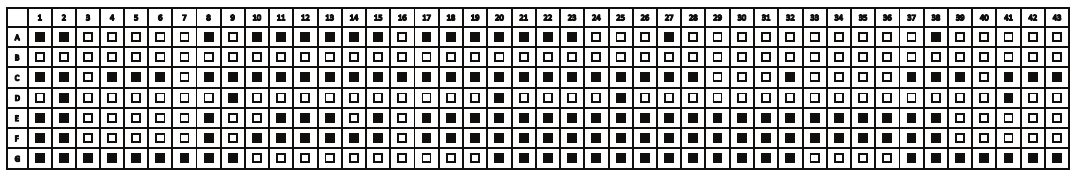
Figure 2: Scanned autorad and schematic representation showing spoligotyping pattern of isolate from the goat with tuberculous lesion caused by M. tuberculosis . A: M. bovis SB1176 (positive control); B: Qiagen H 2 O (negative control); C: M. tuberculosis (positive control); D–F: sample from other animals, G: SIT149 (isolate from goat). The black rectangles represent presence of spacers, and the white rectangles indicate absence of